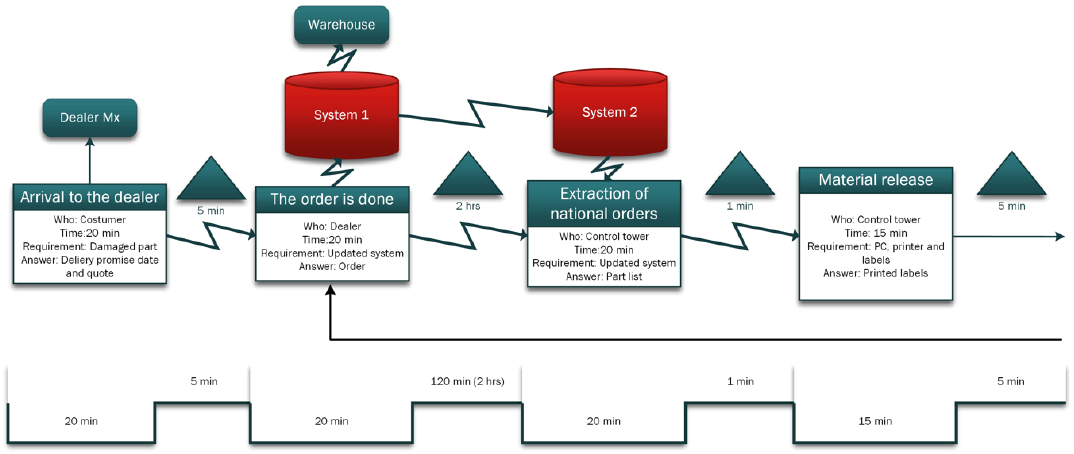
Figure 19. The first part of four of the future state map is displayed.